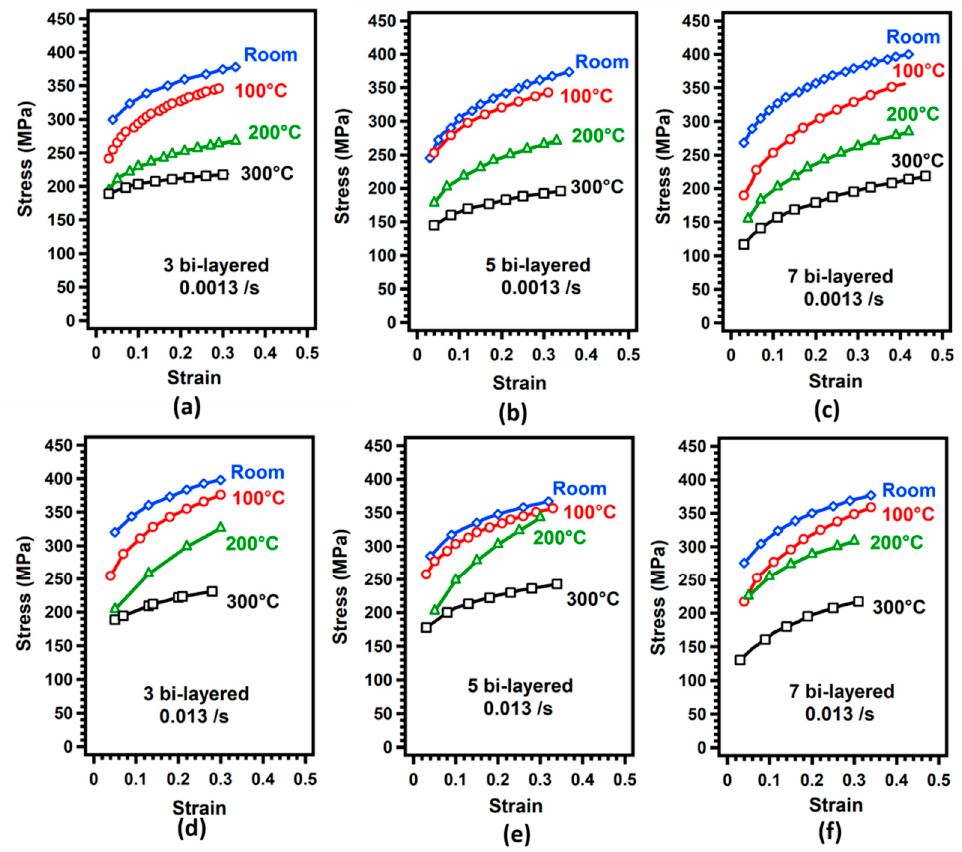
Figure 9. Stress-strain curves obtained from bulge tests for laminated metal composites: ( a – c ) at a strain rate of 0.0013/s and ( b – f ) at a strain rate of 0.013/s.